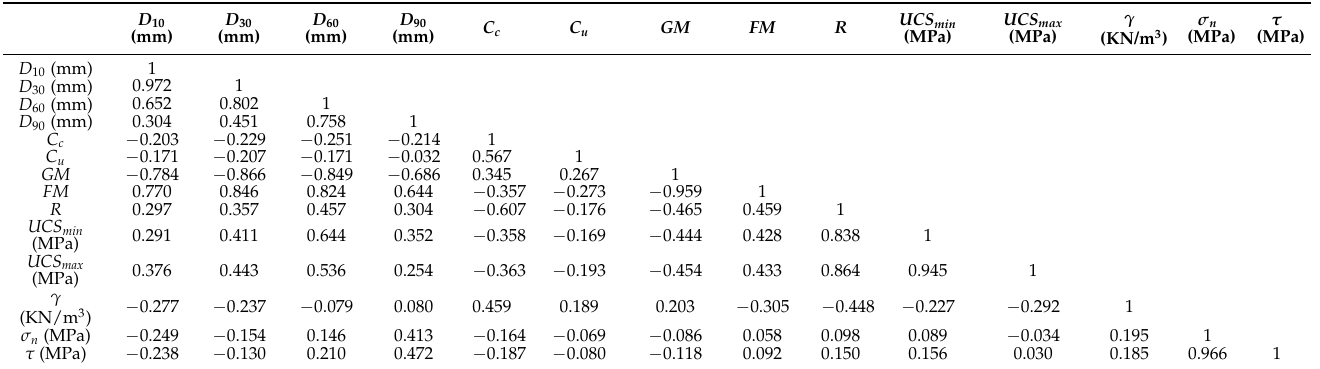
Table 3. Pearson correlation coefficients for variable inputs and the target